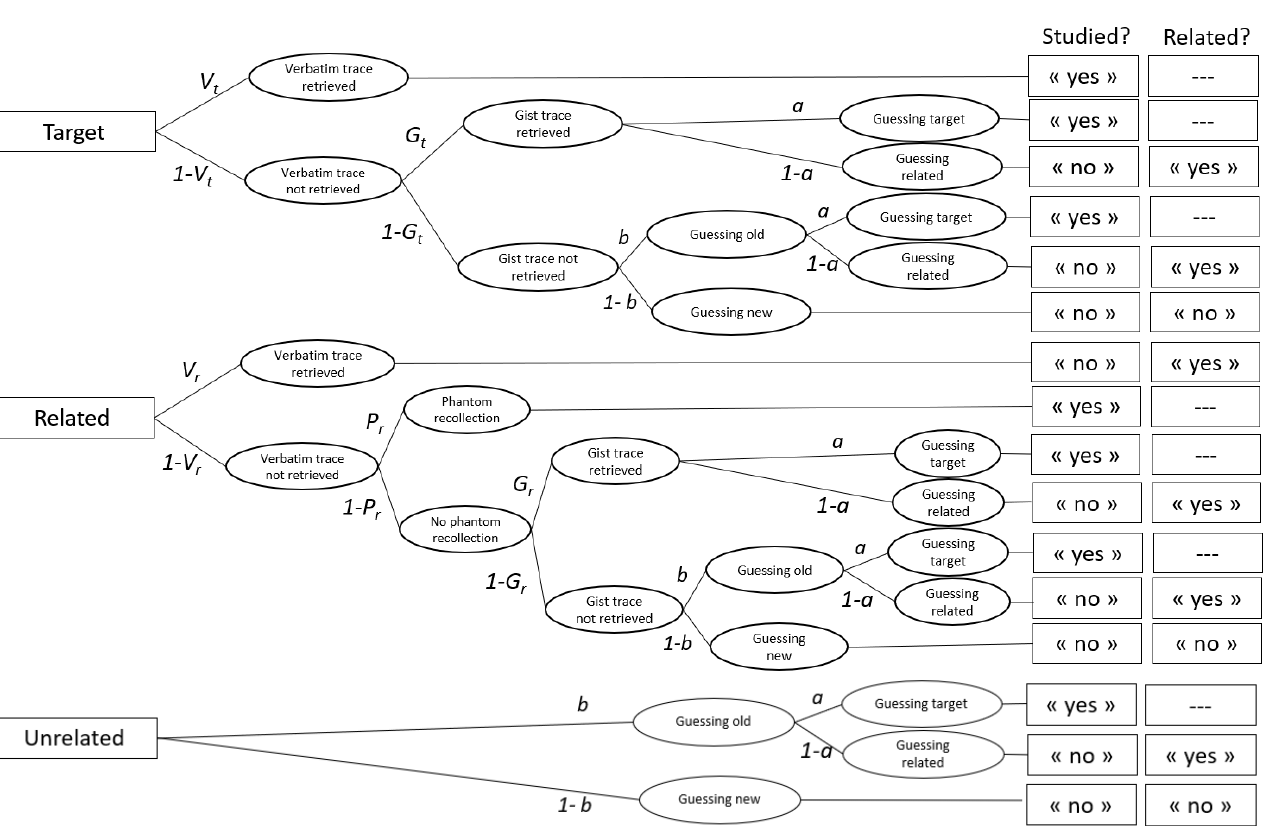
Figure 3. Processing tree for the simplified CR model based on Stahl and Klauer (2009). Note: Rectangles on the left represent probe types, and those on the right represent responses to questions “Was the word in the study list?” and “Was the word related with a word in the study list?”. They are connected by branches that represent the combination of cognitive processes postulated by the model.